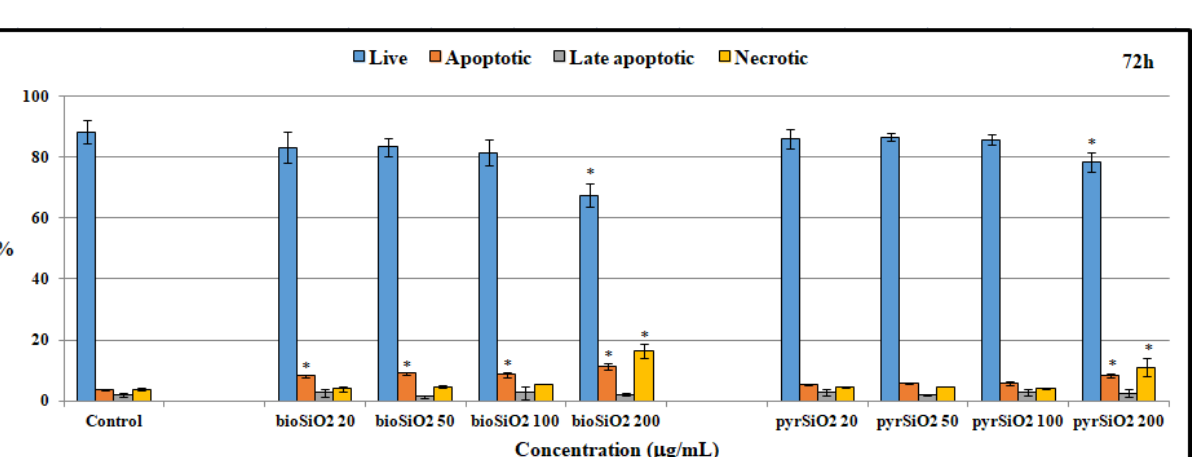
Table 1. The effect of the silica nanoparticles on the cell cycle. The percentage of the distribution of the G1, S, and G2 stages of the HMEC-1 cell cycle after 72 h of incubating cells with nanosilica. Statistical evaluation of